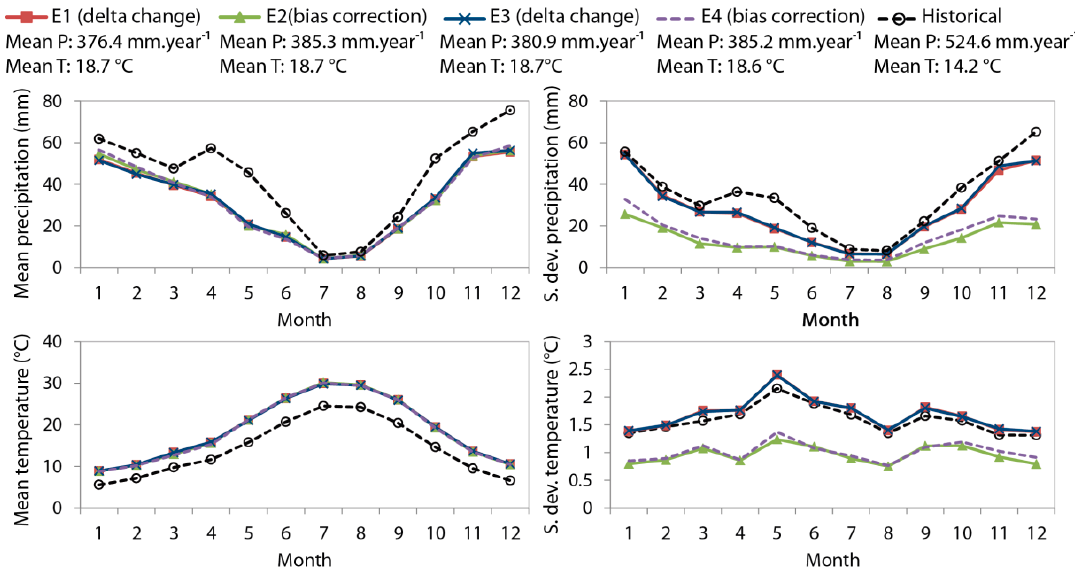
Figure 12. Mean and standard deviation of future precipitation and temperature series obtained by the four ensemble options (E1, E2, E3, and E4)—lumped approaches.